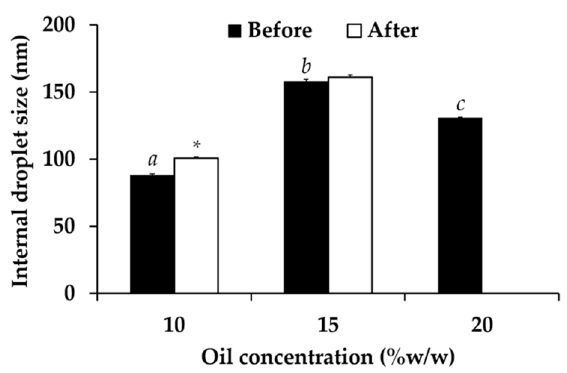
Figure 10. Internal droplet size of nanoemulsion generated using various amount of oil, including 10, 15, and 20% w / w , before and after 8 cycles of heating-cooling condition. The letters a, b, and c denoted significant di ff erence between formulations analyzed using post-hock Tukey ANOVA ( p < 0.05). Asterisk (*) denoted significant di ff erence between before and after the stability test analyzed using t -test ( p < 0.05).